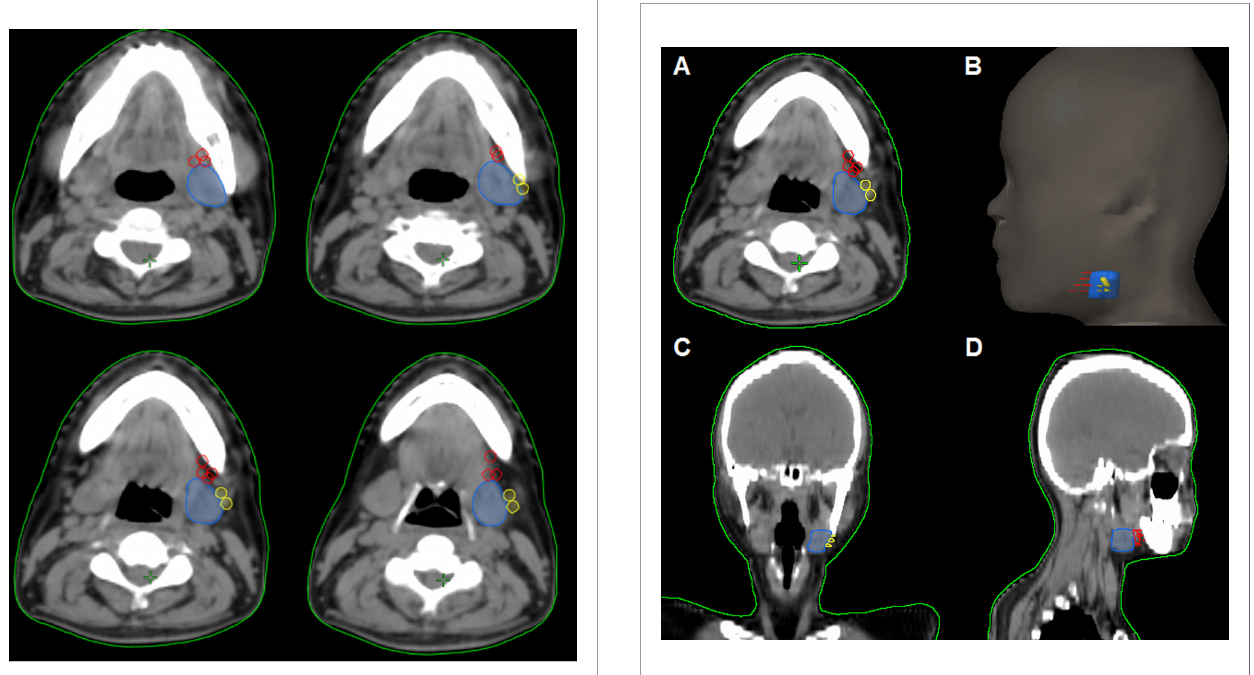
FIGURE 2 | The patterns of peri-submandibular lymph node metastases in oral squamous cell carcinoma (blue, submandibular gland; red, lymph node metastases in the anterior part of the submandibular gland; yellow, lymph node metastases in the lateral part of the submandibular gland).